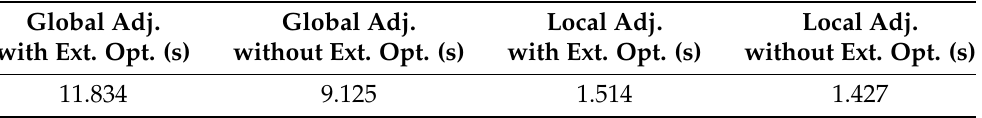
Table 2. Execution Times of Global and Local Adjustments With or Without Optimizing the Spatial- Temporal Parameters 1